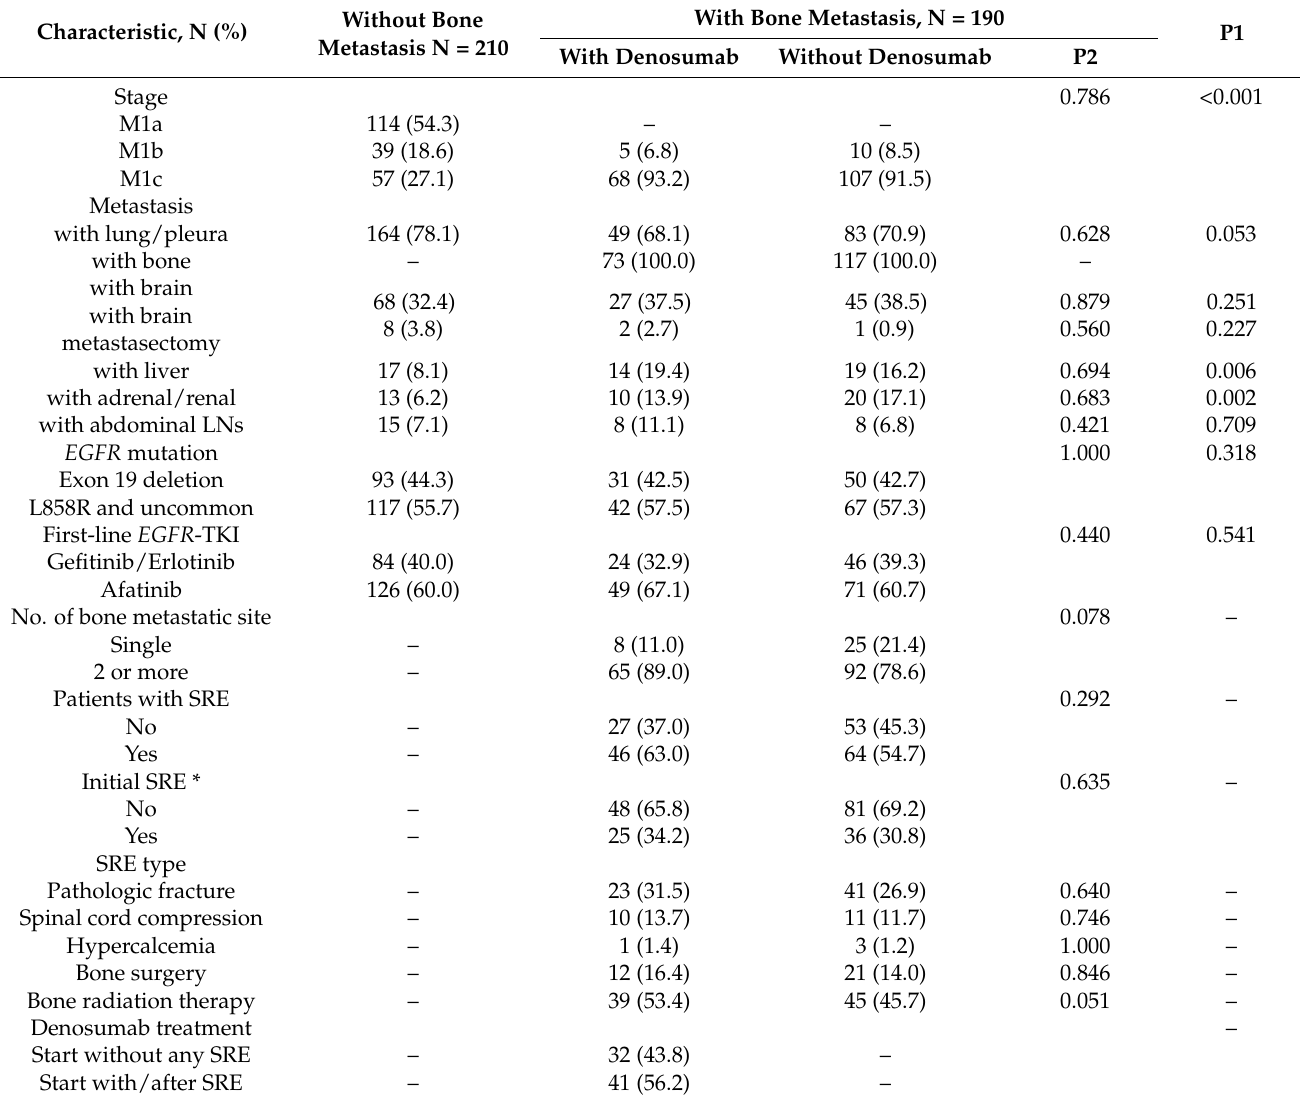
P1: comparison between EGFR -mutated NSCLC patients with and without bone metastasis. P2: comparison between bone metastatic patients with and without denosumab treatment. ECOG PS: Eastern Cooperative Oncology Group performance status; EGFR : epidermal growth factor receptor; LNs: lymph nodes; NSCLC: non-small cell lung cancer; TKI: tyrosine kinase inhibitor; SRE: skeletal-related event. * SRE at the time of initial NSCLC